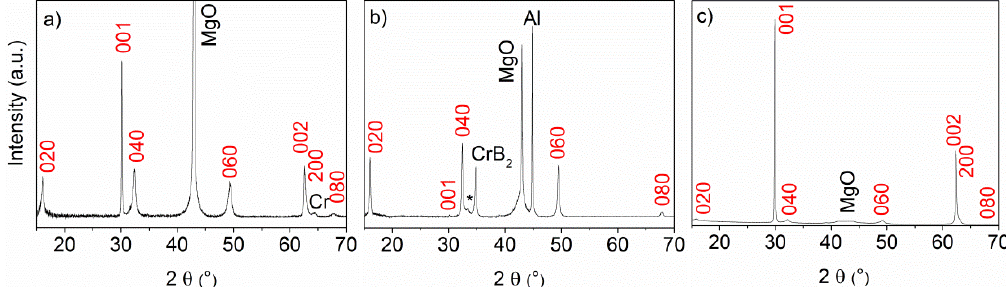
Figure 3. θ–2θ X-ray diffraction scans (λ = 1.5406 Å ) collected on films grown on MgO substrates placed ( a ) close to the Al target at position A, ( b ) close to the Al-B target at position B (with a small peak from the (030) reflection of Cr 3 AlB 4 indicated by a star), ( c ) far from the Al target at position C (with the MgO peak masked).